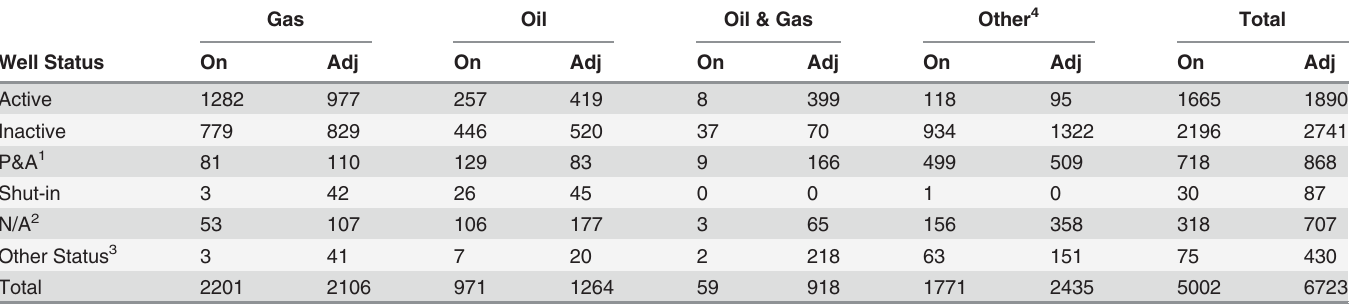
Table 3. Number of wells by Production Type and Status in and adjacent to NWRS units (On = within NWRS unit boundaries) (Adj = Adjacent within 804 meters (m) (0.5 miles) of NWRS unit boundaries). Gas